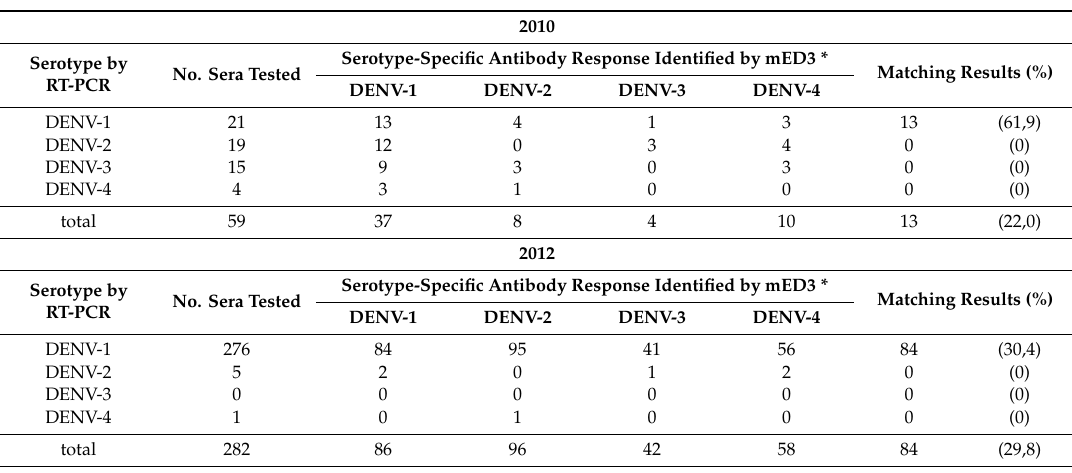
Table 4. Comparison of mED3 antibody responses and DENV serotypes detected by